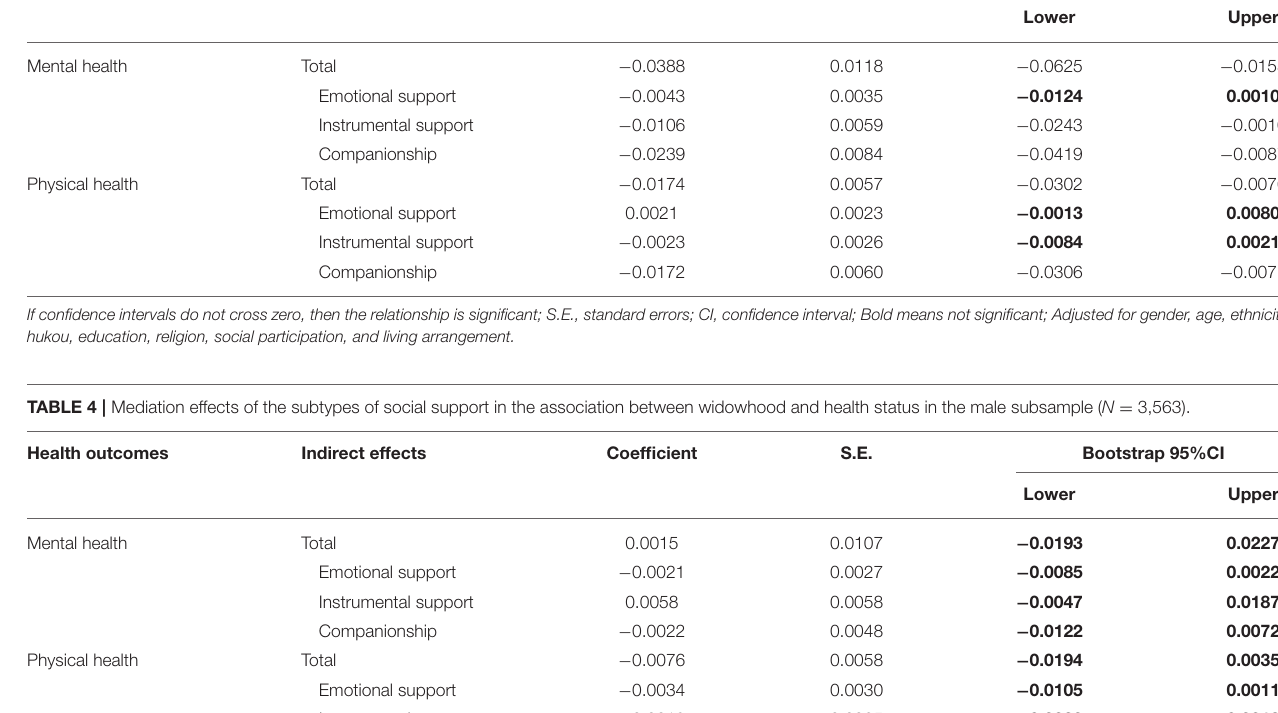
TABLE 3 | Mediation effects of the subtypes of social support in the association between widowhood and health status in the female subsample ( N = 4,084). Health outcomes